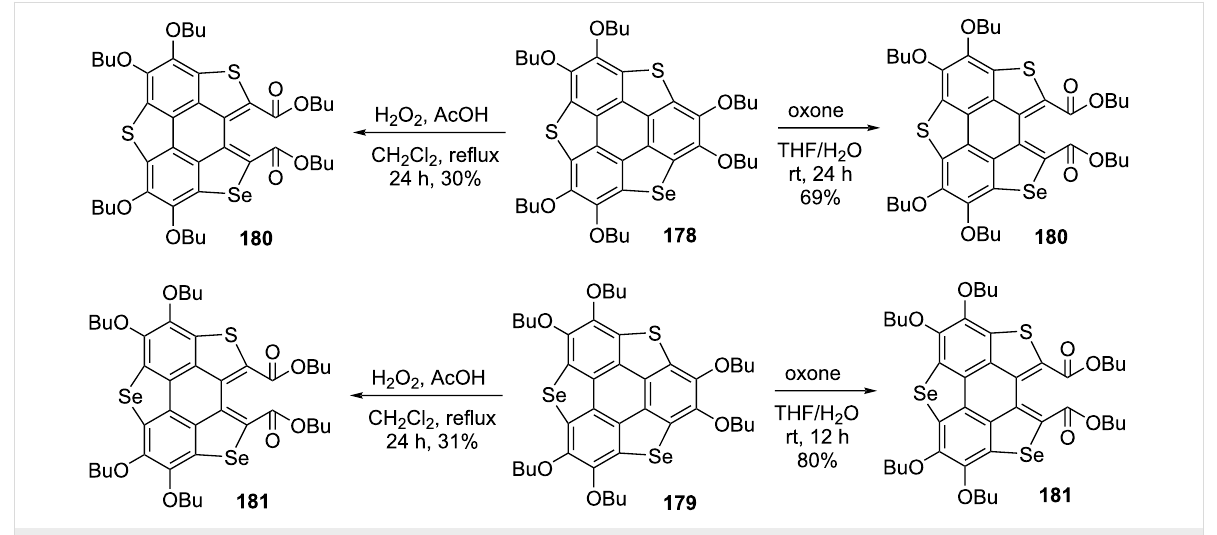
Scheme 46: Ring-opening reaction with H 2 O 2 and oxone of heterasumanenes 178 and 179